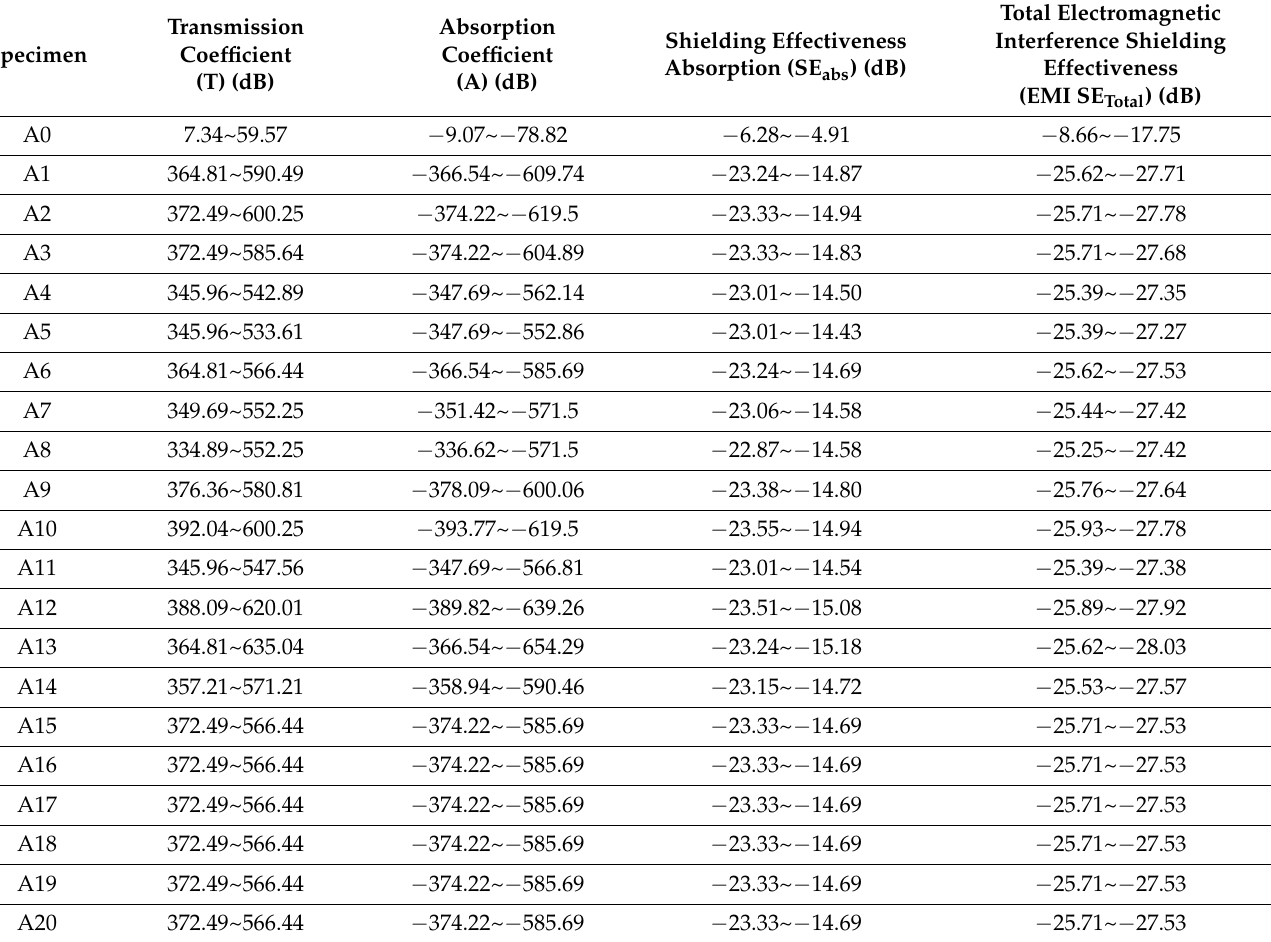
Table 3 indicates the physical properties and EMI results for the experimental designs (L20) with different weight percentages from the RSM central composite design. The weight variation of each polyurethane foam indicates the presence of nanoparticles. The percentage of weight achieved after reinforcement using absorption and the hydrothermal process is shown in Table 3. As shown in Table 3, with a GNP weight percentage of 0.3, ZrO 2 weight percentage of 0.3, and BC weight percentage of 2.5, specimen A13 exhibits the highest maximum EMI value of 25.2 dB. The EMI SE of nanocomposites is affected by morphology, GNP, ZrO 2 and BC loading, incident radiation frequency, matrix composition, and nanocomposite thickness. Table 4 depicts the EMI shielding effectiveness, which is SE Total , of various nanocomposites over the frequency ranges of 8–12 GHz, derived using Equations(1)–(6), as well as the parameters obtained using Equations (1)–(4) for the free air medium shown in Table 5. Due to the limit of the measurement equipment, we only analyzed the effective contribution of different attenuating mechanisms in the X-band frequency range. Table 4 shows that in the frequency range of 8–12 GHz, the experimental specimen A13 has the highest EMI shielding effectiveness of − 25.62 dB to − 28.03 dB. Based on these findings, we concluded that the EMI SE of nanoparticle-reinforced PU foam has improved, comparing specimen A without nanoparticles, which has an EMI shielding effectiveness ranging from − 8.66 dB to − 17.75 dB. The shielding effectiveness value’s pessimistic sign denotes the breakdown of the electromagnetic wave power to the incident electromagnetic wave. Table 4. Diagnostic calculation of EMI SE for non-reinforced and reinforced